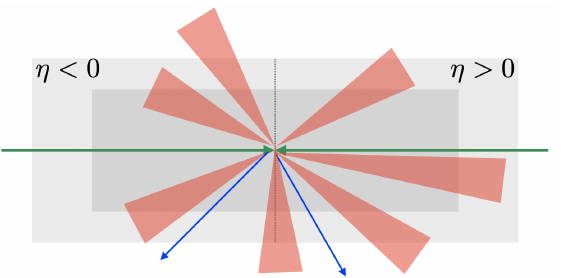
Figure 4. Schematic representation of an event reconstructed at the ATLAS experiment; many jets are present in the event since the LHC is a hadronic